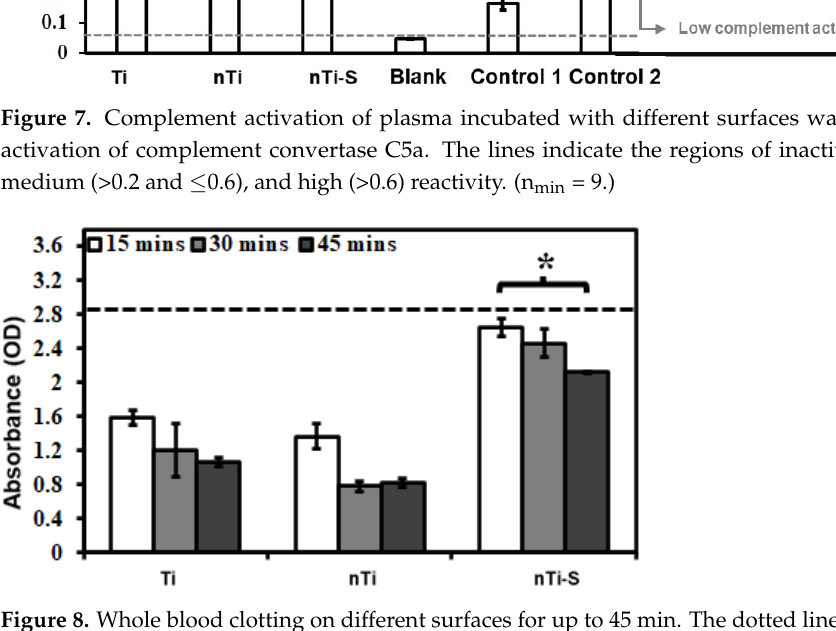
Figure 8. Whole blood clotting on different surfaces for up to 45 min. The dotted line represents the absorbance of free hemoglobin in un-clotted blood. (* p < 0.05; n min = 9.)